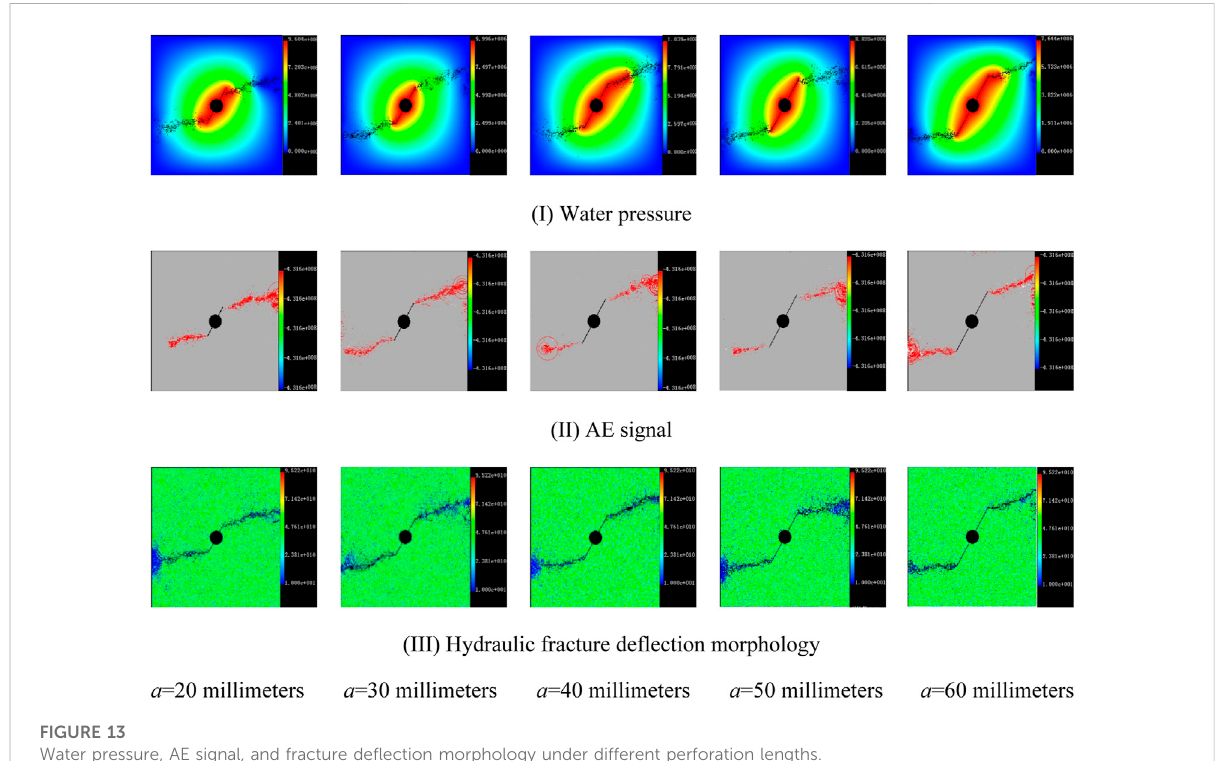
FIGURE 13 Water pressure, AE signal, and fracture de fl ection morphology under different perforation lengths.